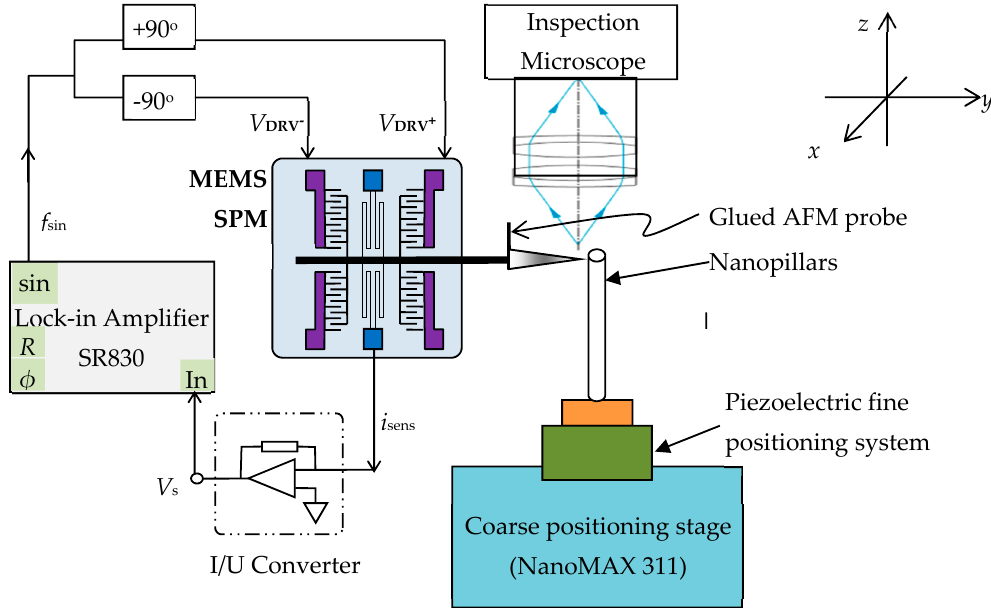
Figure 4. Experimental setup of the MEMS-SPM for nanomechanical measurements.